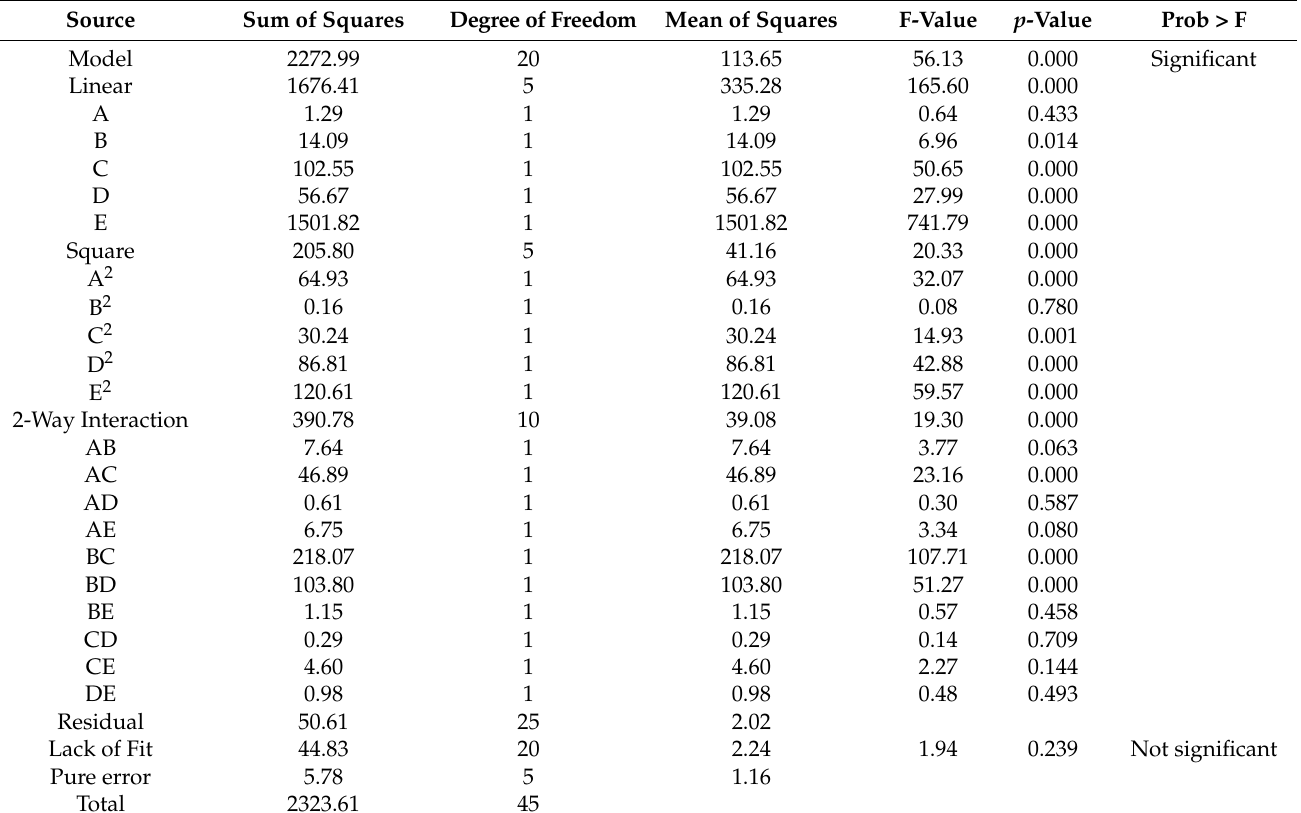
Table 5. ANOVA for the experimental results of cellulase biosynthesis by M. hiemalis .